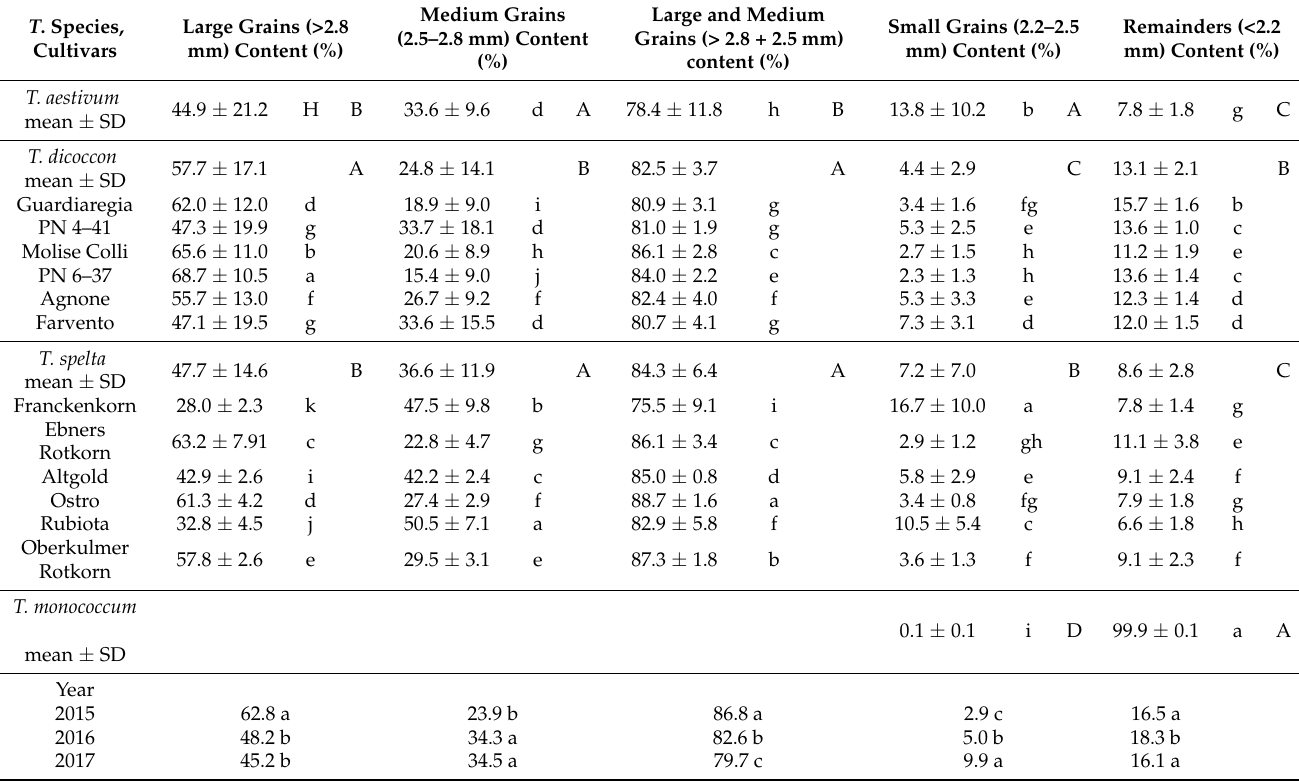
Table 7. Grain quality parameters of Triticum species and